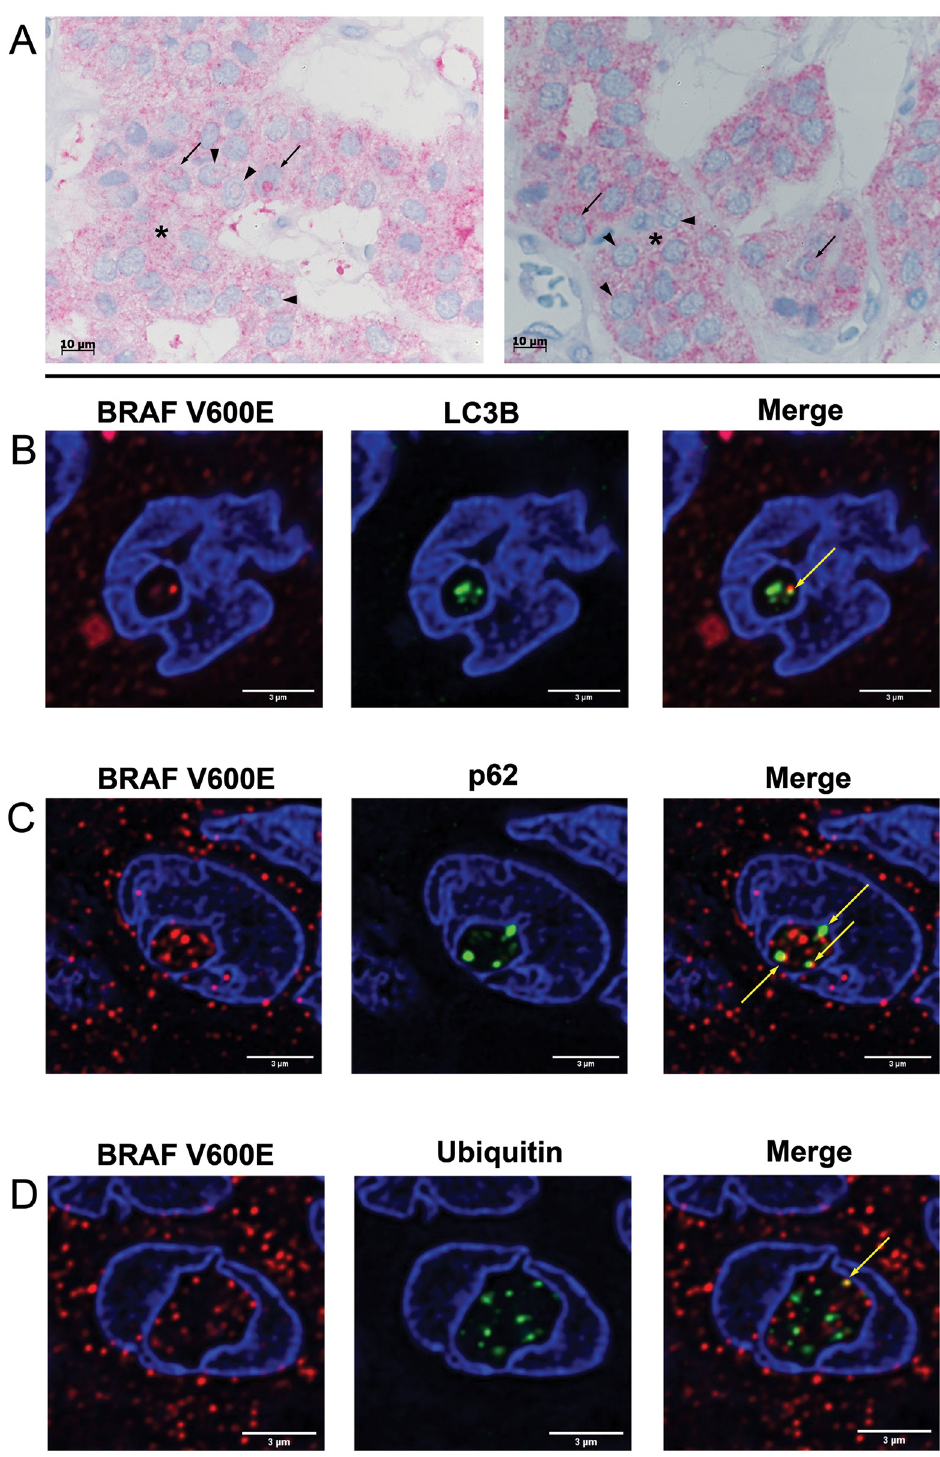
Fig 5. Study of mutant BRAF protein found within the inclusions. (A) BRAF V600E -IHC analysis of PTC sections depicts additional to cytoplasmic immunopositivity (asterix) an accumulation of BRAF V600E within the intranuclear inclusions (NI). The left image display NI with varying degrees of immunoreactivity for BRAF V600E with very strong immunostaining within the NI (arrows) and weaker staining (arrowheads). The right image demonstrates NI containing an accumulation of BRAF V600E (arrows) and NI with almost no immunoreactivity for mutant